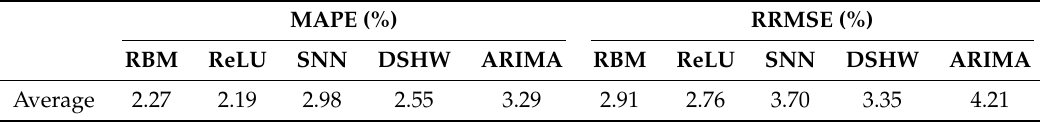
Table 4. Error table of the aggregated